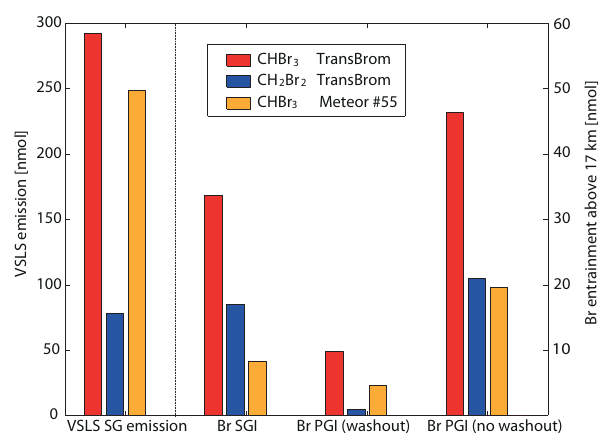
Fig. 4. Average SG emissions of CHBr 3 and CH 2 Br 2 observed in the West Pacific during the TransBrom Sonne campaign and in the tropical Atlantic during the Meteor #55 campaign are shown (left side). Estimates of bromine SGI, bromine PGI in case of Br y washout and bromine PGI in case of no Br y washout have been de- rived based on the emissions and are also displayed (right